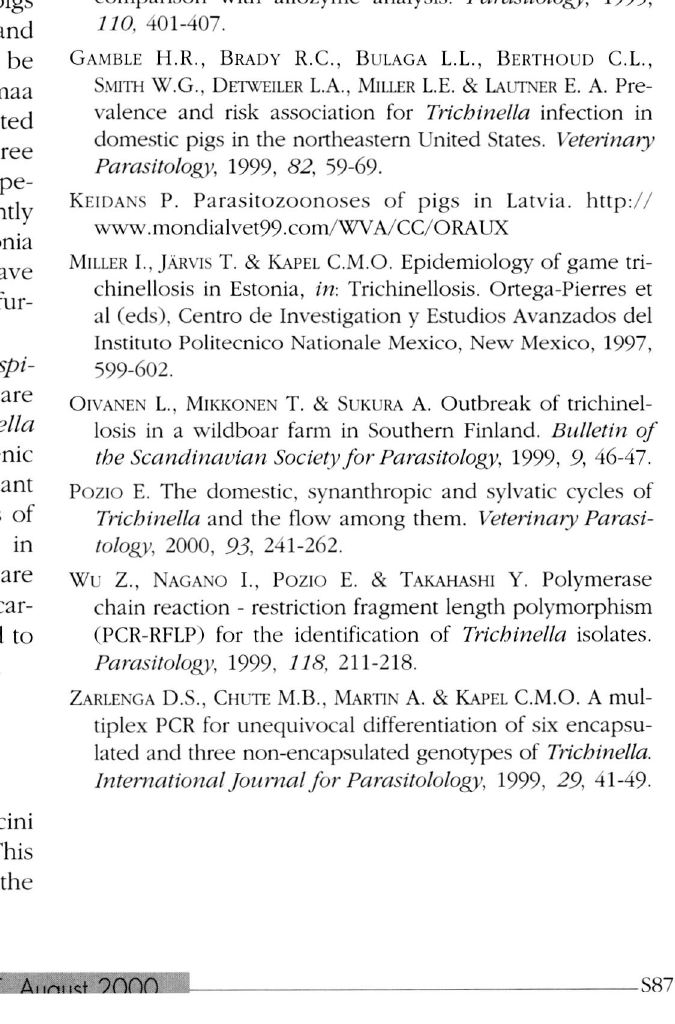
gerous and widely spread helminthozoonosis in pigs ; in the period from 1976 to 1998, the prevalence of infection in wild boar populations of Latvia ranged bet ween 1.3 % to 3.2 % (Keidans, 1999). In Estonia, about 1 % of the examined wild boars were